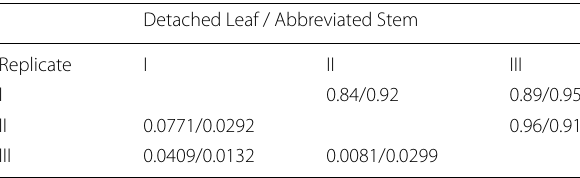
Table 2 The correlation between each replicate of detached leaf and abbreviated stem, above the diagonal indicates the correlation coefficient (r) and below the diagonal